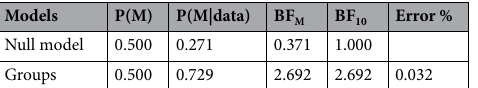
Table 3. Bayesian one-way ANOVA model comparison for God Image Score.